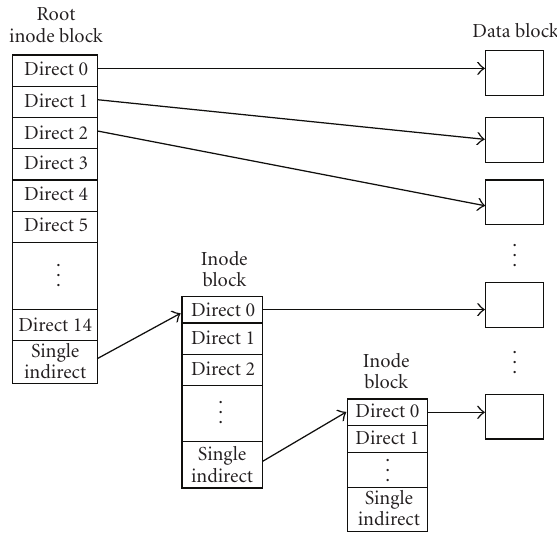
Figure 4: HWFS Inode